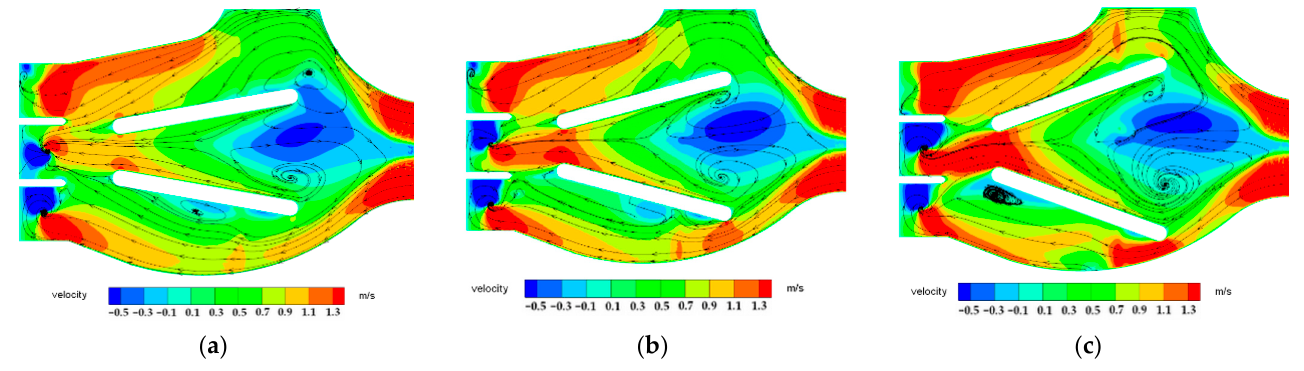
Figure 12. Comparison of bottom streamline and velocity cloud images at different angles. ( a ) 20 ° , ( b ) 30 ° , and ( c ) 40 ° .